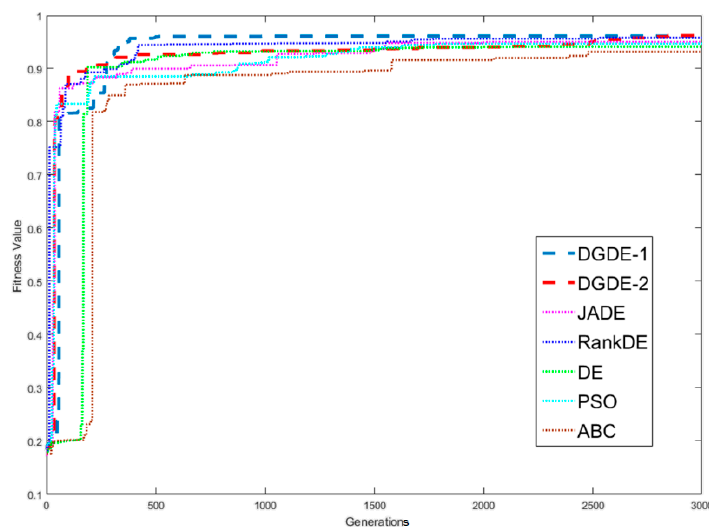
Figure 15. Learning curves of the wall-following control when various evolutionary algorithms are employed. Table 5. Fitness value of various algorithms in the testing environments.